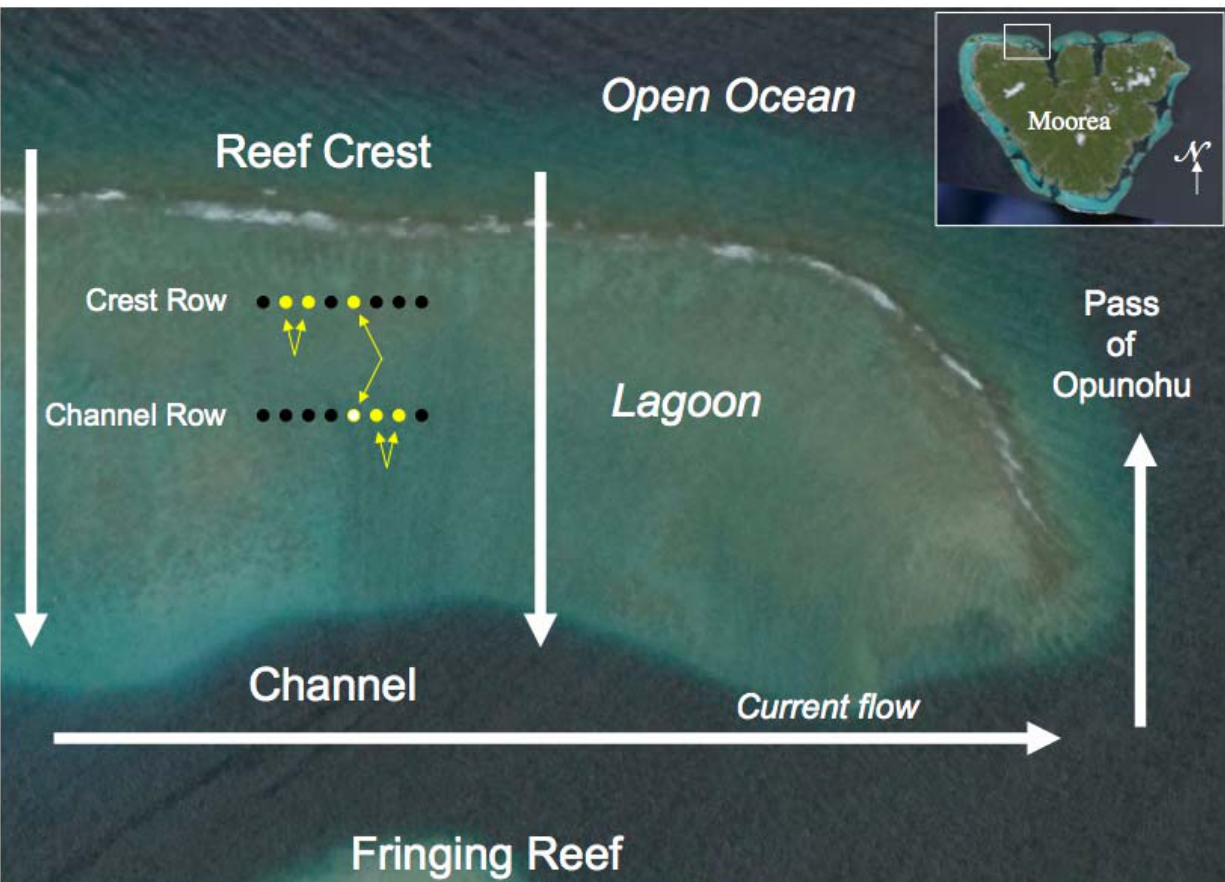
Figure 1. Research site located on the northwestern shore of the island of Moorea, French Polynesia (inset). General water circulation is from the open ocean, over the barrier reef, towards the channel, and then out of the lagoon through the pass (white arrows). We placed 2 rows of 8 anemones (black dots), a Crest Row and a Channel Row. One pair of full sibling fishes was found on Channel Row anemone number 5 (white dot). Two pairs of half siblings were found on adjacent anemones, Channel Row anemones 6 and 7, Crest Row anemones 2 and 3 (yellow dots and yellow arrows). One threesome of half sibs included two individuals in one anemone (channel 5) and one individual on the Crest Row (anemone 5), indicated by yellow and white dots and yellow arrows.